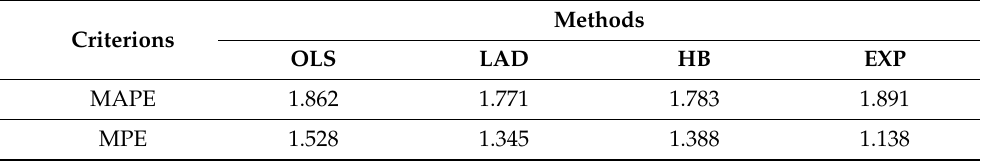
Table 6. MAPE and MPE of three estimation methods under